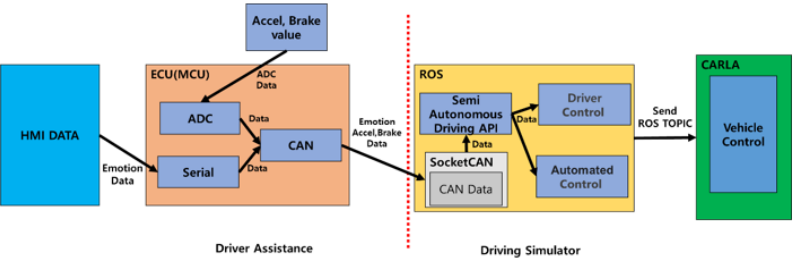
Figure 5. Driver assistance systems.